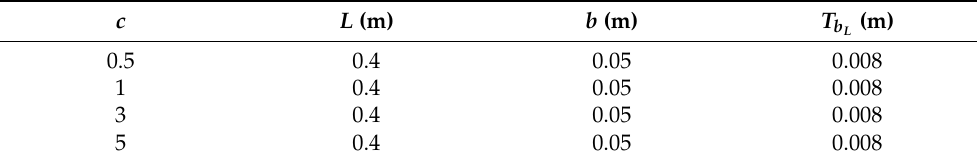
Table 1. Tapered beam geometric specifications.